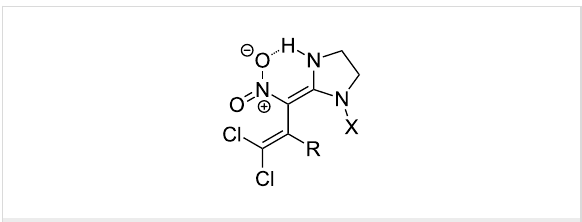
Figure 3: Stabilizing hydrogen bond in nitrobutadiene-derived imida- cloprid analogues 9 – 12 .